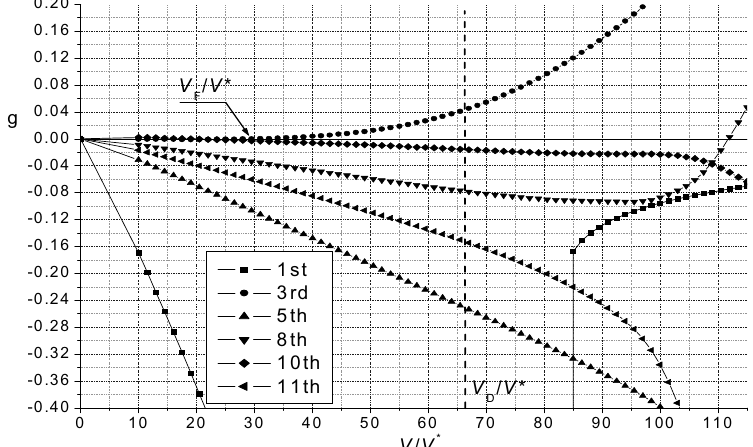
Fig. 2. The V-g locus of nonlinear pre-stressed wing.